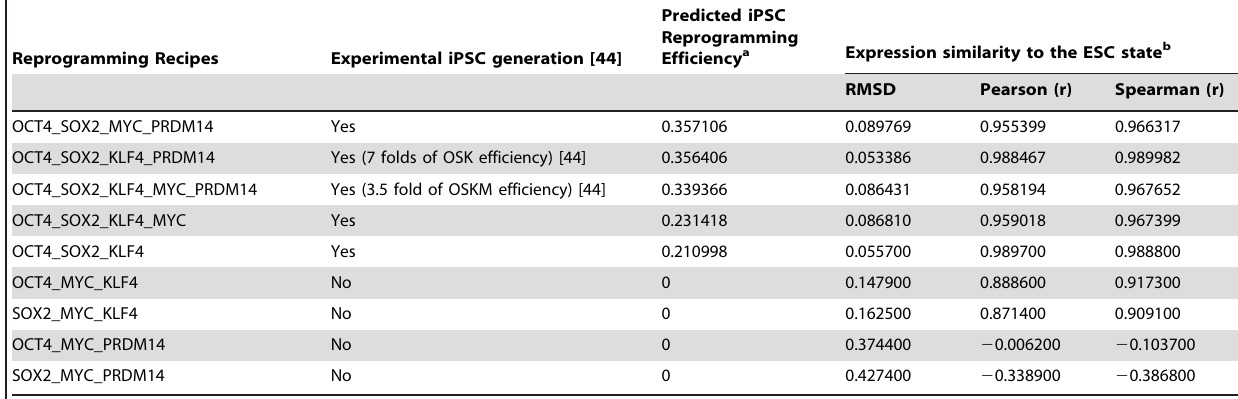
Table 1. Experimentally validated reprogramming recipes.